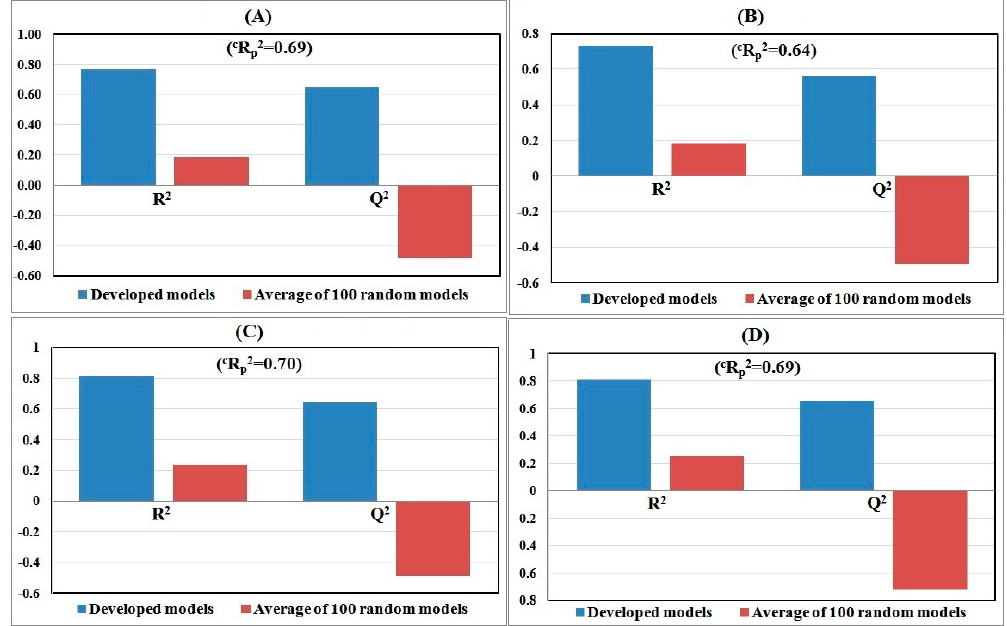
Figure 2. Randomization plots of QSPR models developed with the following dataset splitting methods: ( A ) Activity sorted; ( B ) Euclidean distance based; ( C ) Kennard–Stone based; and ( D ) K-Medoid clustering.